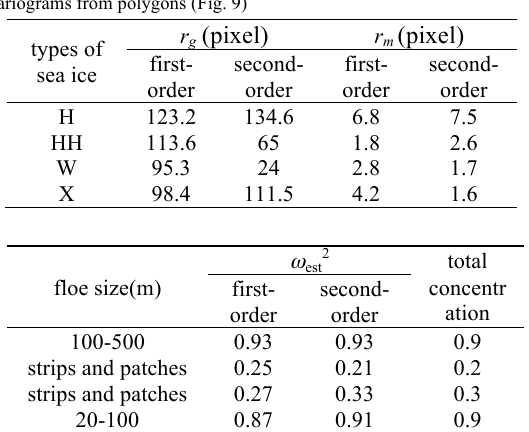
Table 2. Parameter estimation results of polygons in Fig. 9